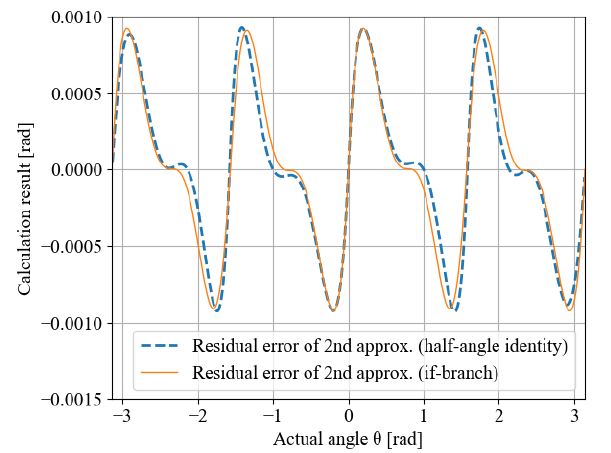
Figure 7. Residual error of 2nd approximation of atan2 (plot using x = cos θ , y = sin θ